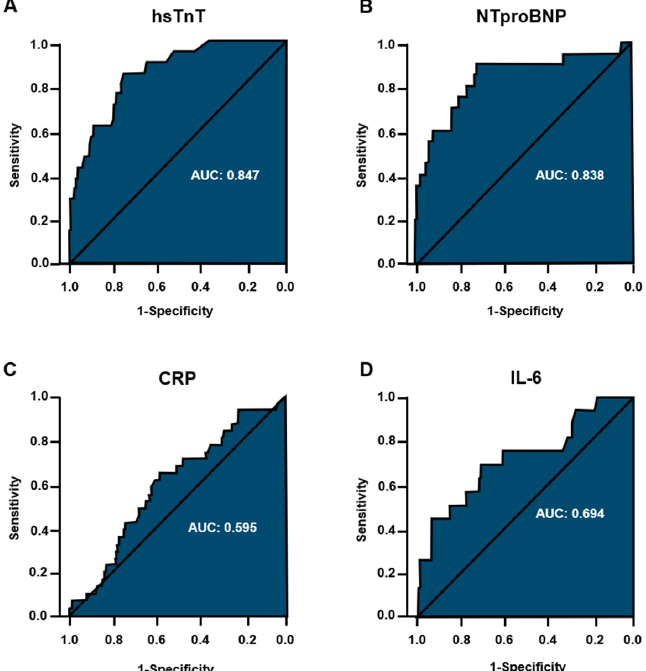
Figure 3. Receiver operating characteristic curve (ROC) analyses for biomarkers in relation to incident arrhythmia. ROC curves and the corresponding area under the curve (AUC) values were calculated after conducting univariate logistic regression modeling to predict incident arrhythmia for each biomarker, respectively. ( A ) hsTNT = high-sensitive troponin T; optimal cut-off value according to Youden index analysis: 27.5 pg/mL. ( B ) NTproBNP = n -terminal pro-B-type natriuretic peptide; cut-off value: 1518 ng/L. ( C ) CRP = C-reactive protein; cut-off value: 120.5 mg/l. ( D ) IL-6 = interleukin-6; cut ‐ off value: 82.5 ng/L. Table 2. Peak levels of cardiac and inflammatory biomarkers.